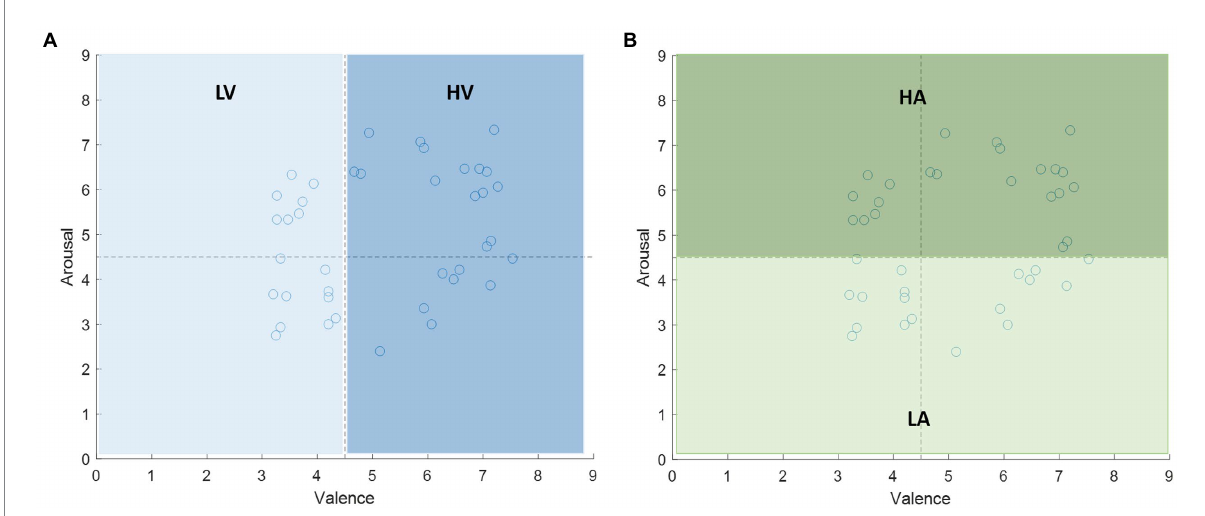
FIGURE 6 The labels of the stimuli on the valence-arousal plane. The median 4.5 is the threshold to divide the rating value into two categories: (A) low valence (LV) and high valence (HV) in valence dimension, (B) low arousal (LA) and high arousal (HA) in arousal